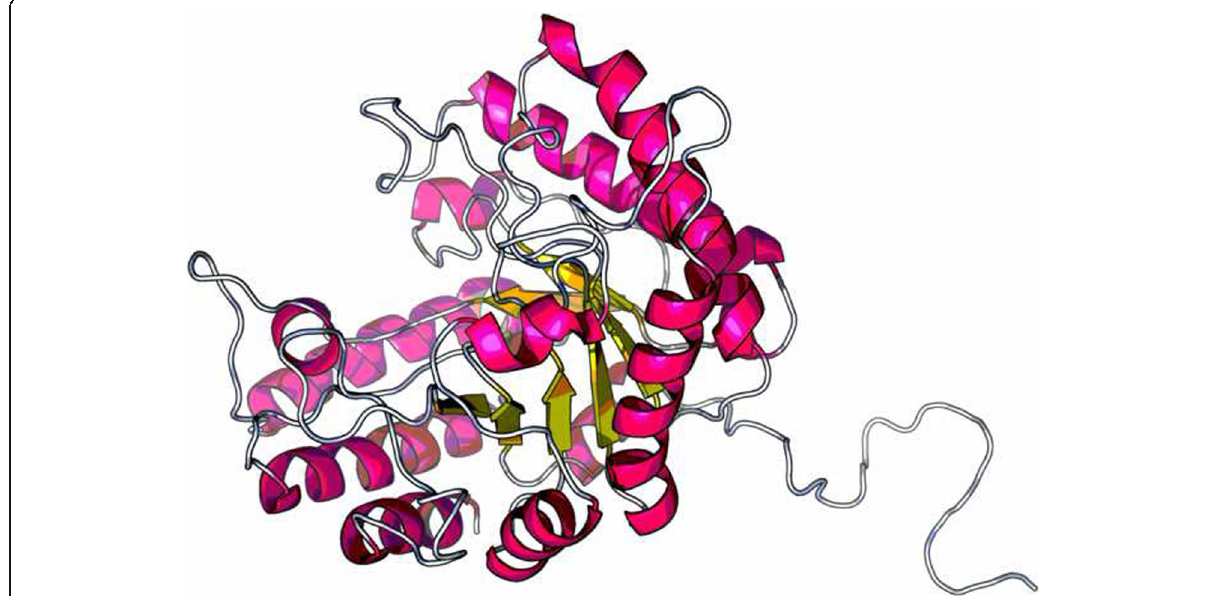
Fig. 4 Predicted 3D structure of cellulase from Ruminococcus albus provided by Raptor X and refined by